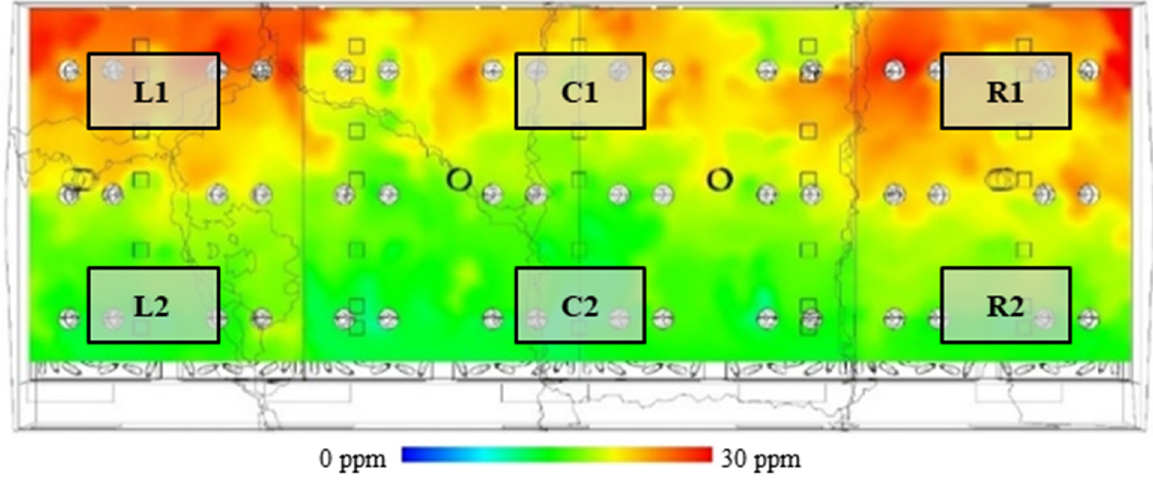
Figure 12. Computed results of ammonia concentration inside the experimental piglet house .